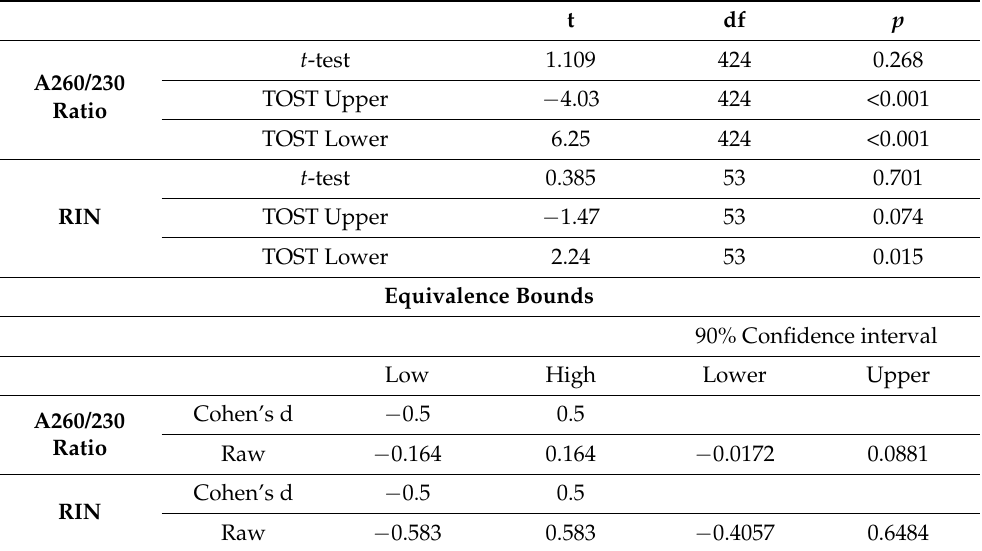
Figure 5. Equivalence plotted using confidence interval approach to explain equivalence between euthanasia methods (ANOXIA TM vs. T-61 ® ) on the variables ( A , B ). The vertical bars depict the upper and lower limits for the effect size parameter, Cohens d. RIN values fall beyond the confidence interval at the upper bound limit, and hence, the two euthanasia methods cannot be considered equivalent based on the RIN values. Table 3. Summary of the Test on Independent Samples t -test—Two One-Sided Test Results.